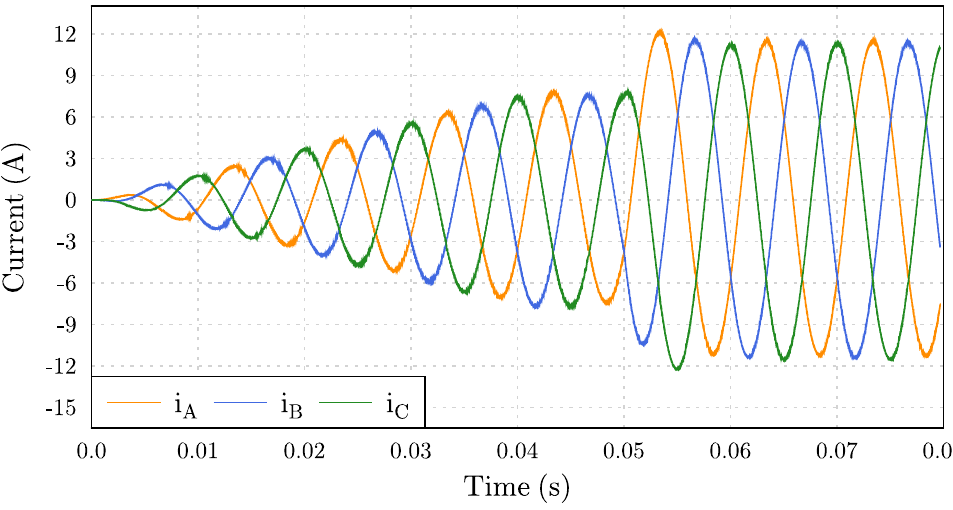
Figure 18. Output currents of the DMC controlled by